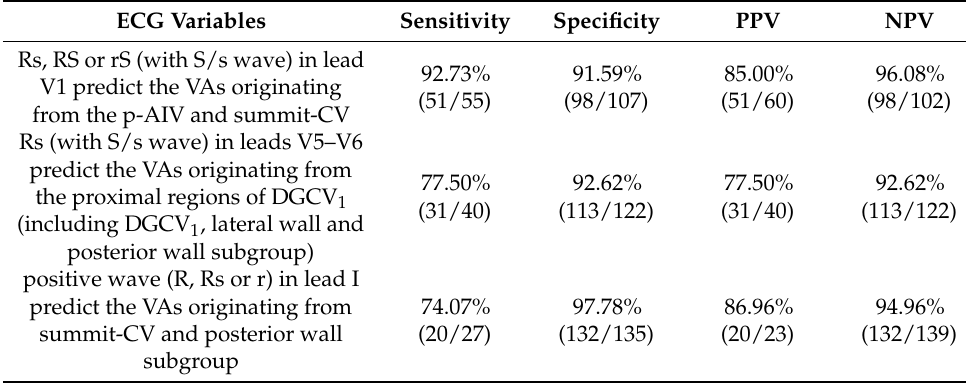
Table 4. The ECG identification of the IVAs originating from the